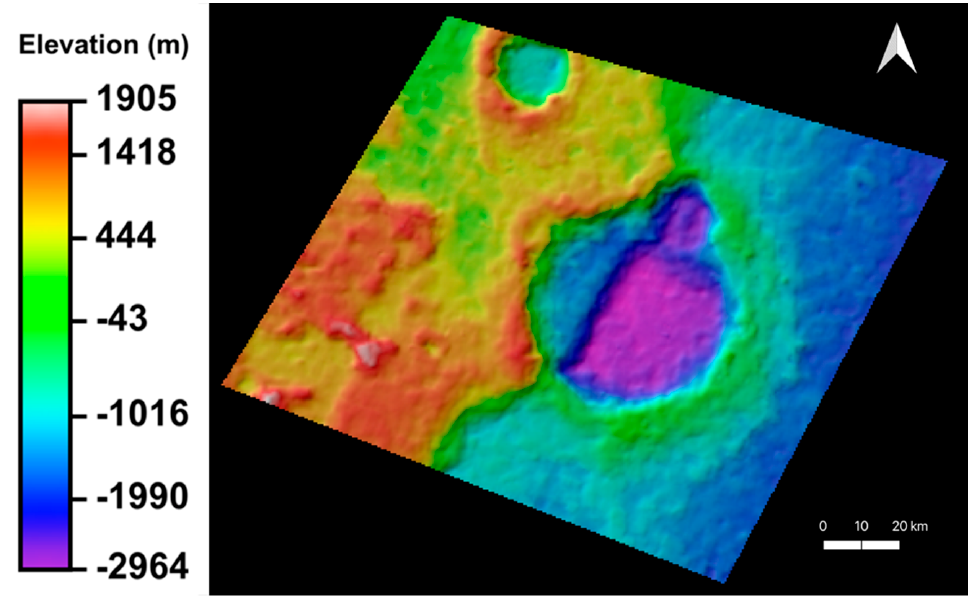
Figure A4. Scarp in northwest Rembrandt Basin.